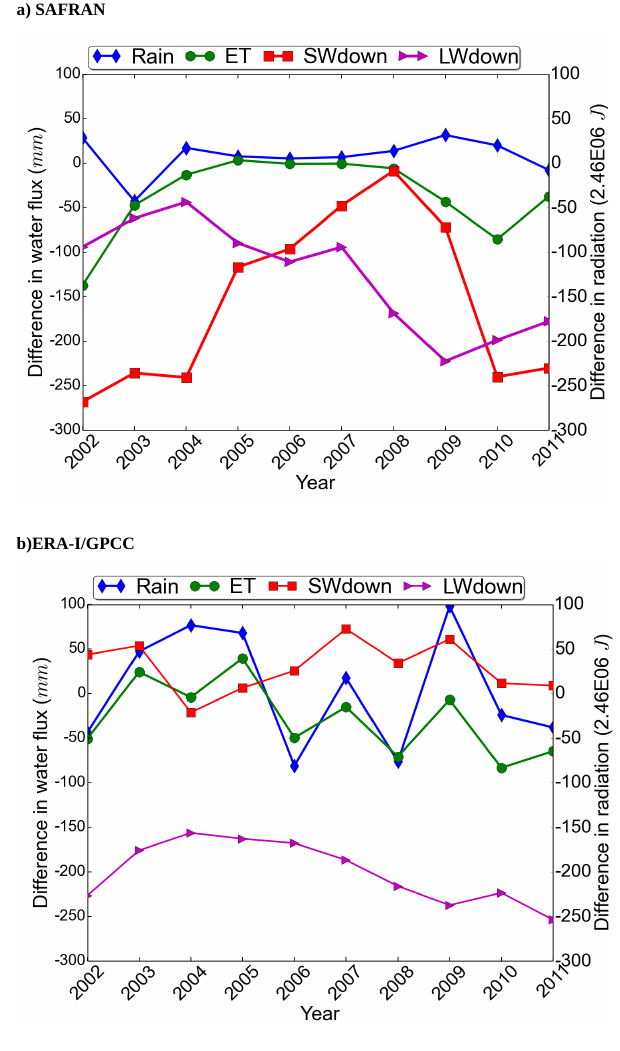
Figure 5. Evaluation of yearly values of shortwave radiation (SWdown), longwave radiation (LWdown), rainfall and simulated evapotranspiration (ET) for SAFRAN (a) and ERA-I/GPCC (b) re- analyses. For radiations and rainfall, the differences in yearly cu- mulative values between the reanalysis and the local observation are represented. For ET, the differences in yearly cumulative val- ues between the simulation achieved with the reanalysis climate (S SAFRAN and S ERA ) and the simulation achieved with the local climate (S CTL ) are shown. The radiation unit is given in 2.46 × 10 6 J to match the water-flux scale given in